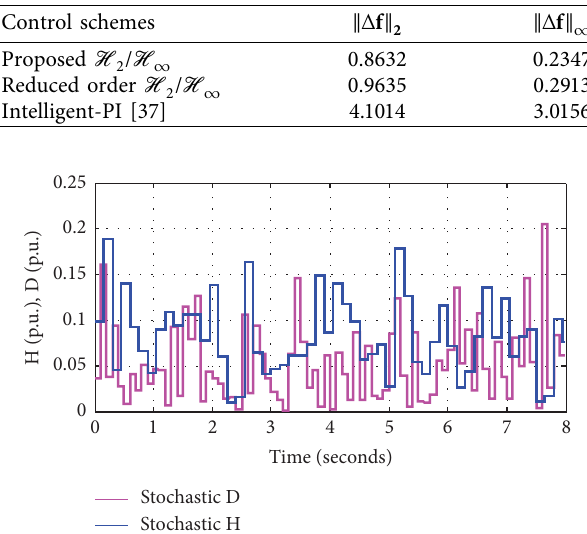
Table 3: Scenario II’s norm specifcation.